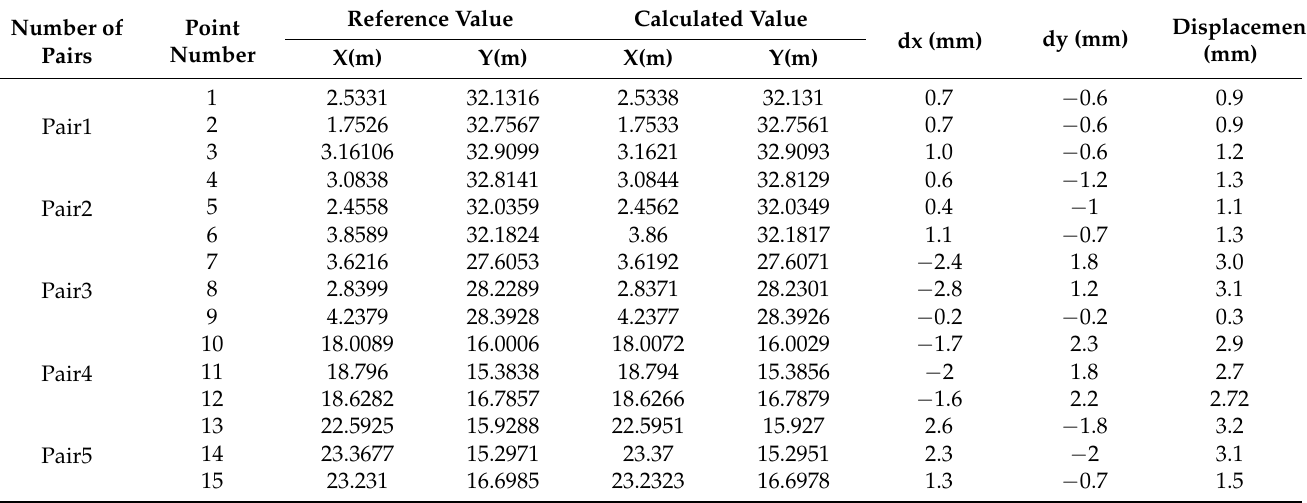
Table 5. The coordinate deviations of 15 homonymous points after